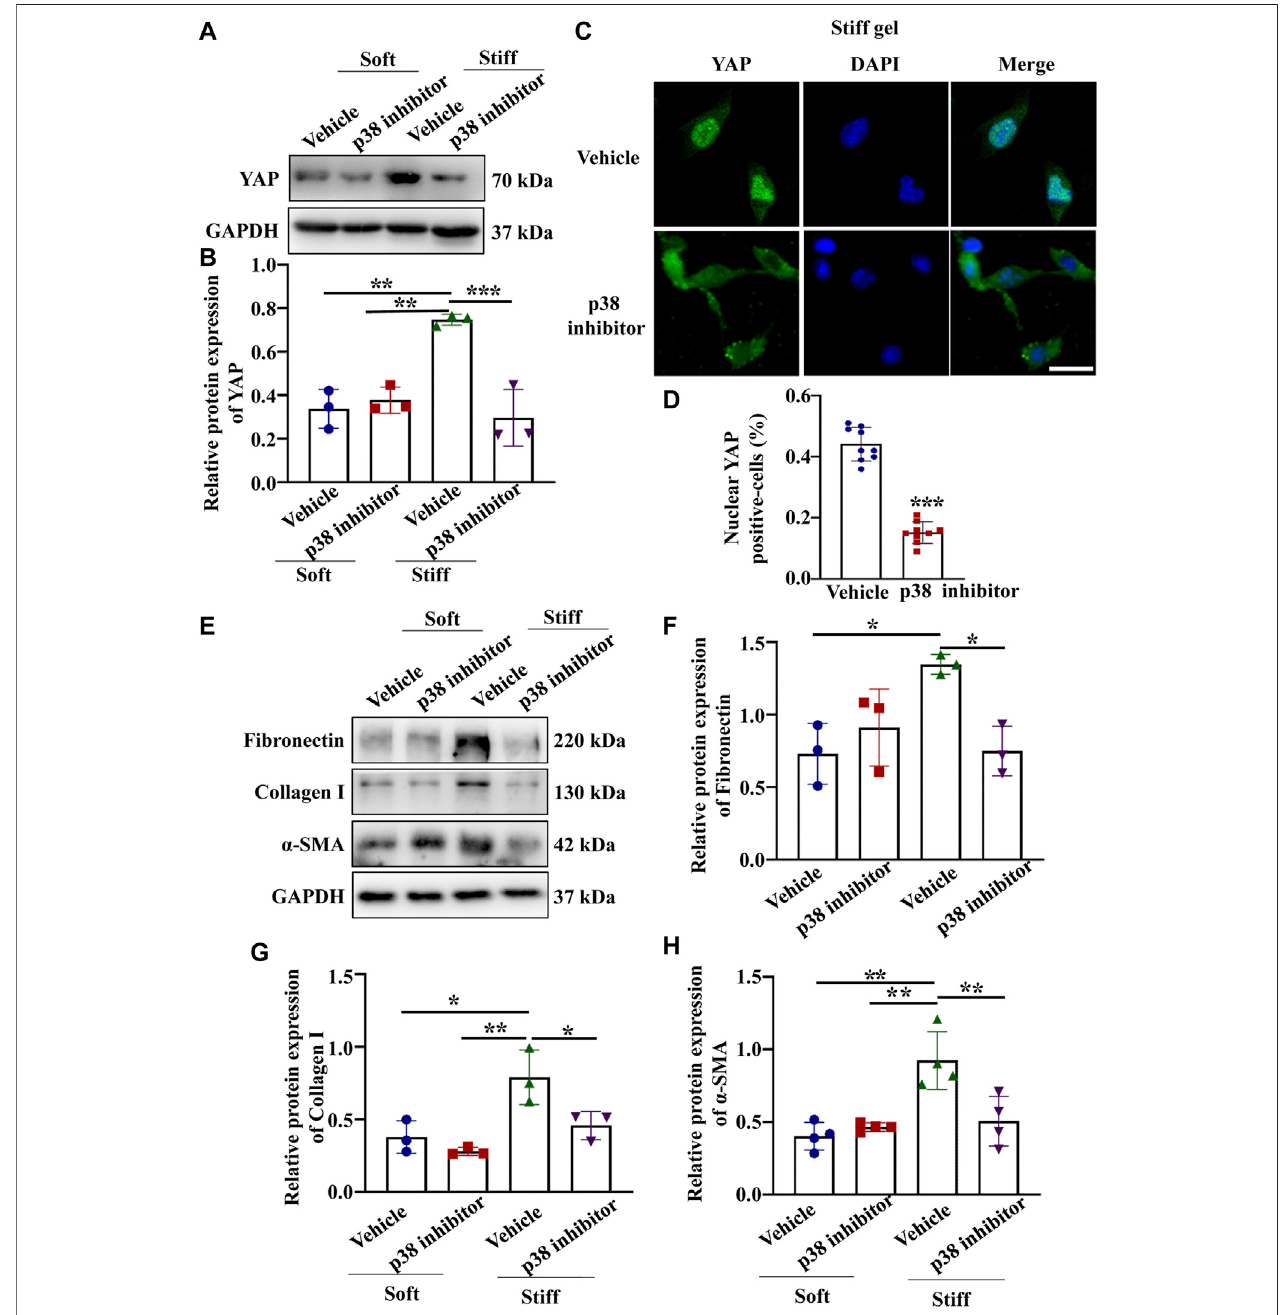
FIGURE4| p38inhibitorblockedYAPactivationandECMproteinexpressioninducedbyenhancedhydrogelstiffness.MCsweretreatedwithvehicleorap38inhibitor andculturedonhydrogelswithdifferentstiffness. (A) RepresentativeWesternblotbandsshowingYAPexpressionineachgroup. (B) Semi-quantitativemeasurementofYAP ( n (cid:1) 3;* p < 0.05,** p < 0.01,*** p < 0.001). (C) Representativephotomicrographshowing fl uorescencestainingofYAPincellstreatedwithvehicleandap38inhibitorgrownon thestiffhydrogels.Scalebar (cid:1) 25 µm. (D) ThepercentageofcellswithpredominantlynuclearYAPstaining.(***, p < 0.001). (E) Representativewesternblotbandsshow theproteinexpressionlevelsofFibronectin,Collagen1and α -SMAafterMCsweretreatedwithvehicleorap38inhibitorand cultured onthesoftandstiffhydrogels.Thebar graph shows the result of semi-quantitative measurement of Fibronectin (F) , Collagen I (G) and α -SMA(H) ( n (cid:1) 3; * p < 0.05, ** p < 0.01, *** p < 0.001).